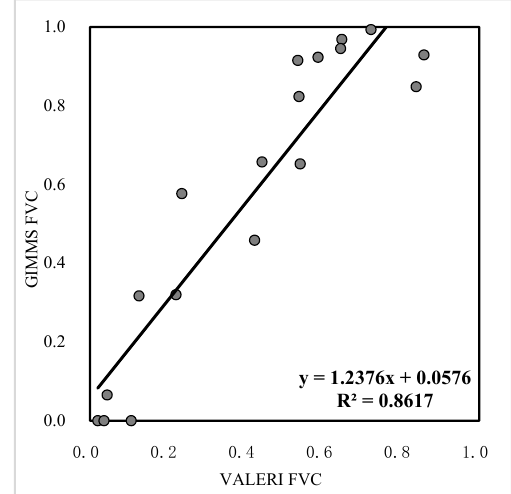
Figure 3. The corresponding scatter plots, including the regression slope, intercept and correlation coefficient between GIMMS FVC and VALERI